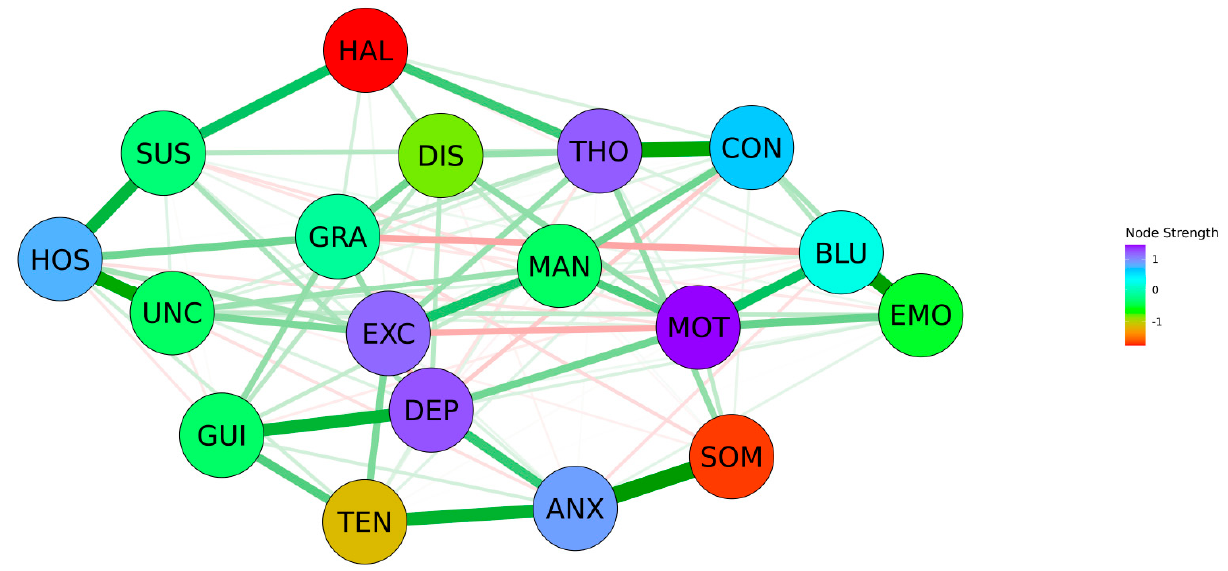
Figure 1. Network structure of the Brief Psychiatric Rating Scale items in Asian patients with schizophrenia ( n = 1438; CS-coefficient = 0.361). Green lines represent positive associations, whereas red lines represent negative associations between the connecting nodes. The thickness of the lines represents the strength of the edges. Abbreviations: ANX, anxiety; BLU, blunted affect; CON, conceptual disorganization; DEP, depressive mood; DIS, disorientation; EMO, emotional withdrawal; EXC, excitement; GRA, grandiosity; GUI, guilt feelings; HAL, hallucinatory behavior; HOS, hostility; MAN, mannerism and posturing; MOT, motor retardation; SOM, somatic concern; SUS, suspiciousness; THO, unusual thought content; UNC, uncooperativeness.